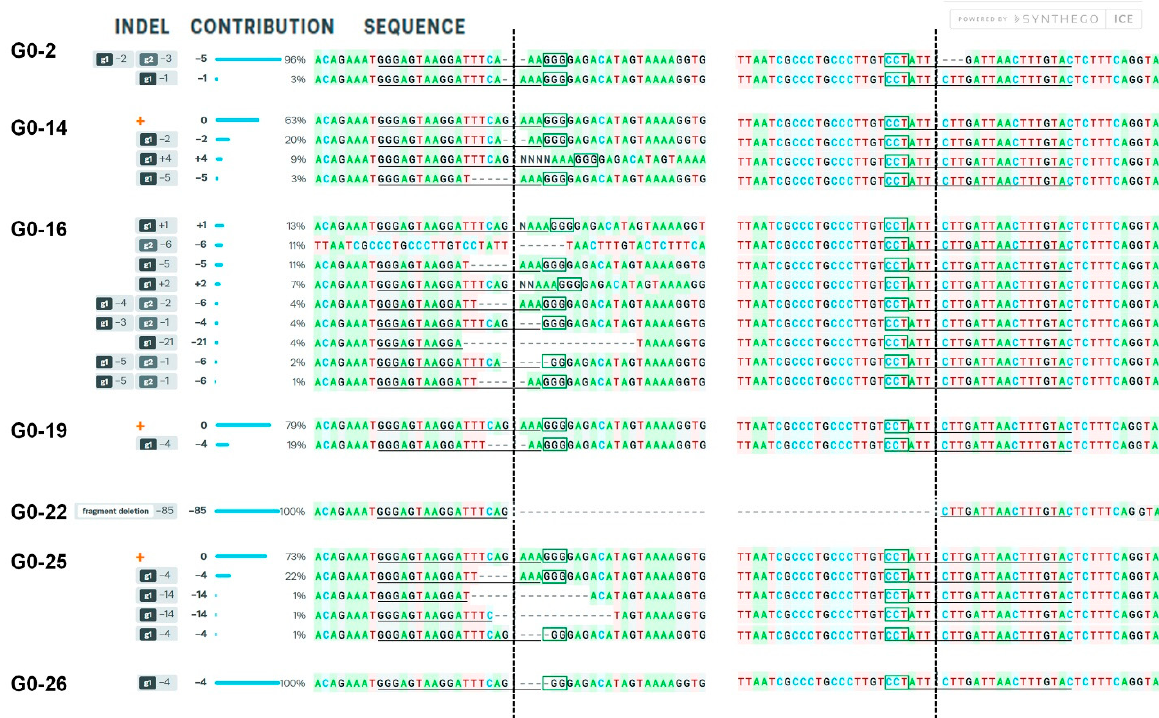
Figure 5. PCR-amplified SlMlo1 -target region of G0 lines was Sanger sequenced and decomposed using the ICE tool to determine the type of mutation (indel) and editing efficiency (contribution) in the analyzed population. Dotted vertical lines denote target cleavage sites. Dashes imply nucleotide deletions.